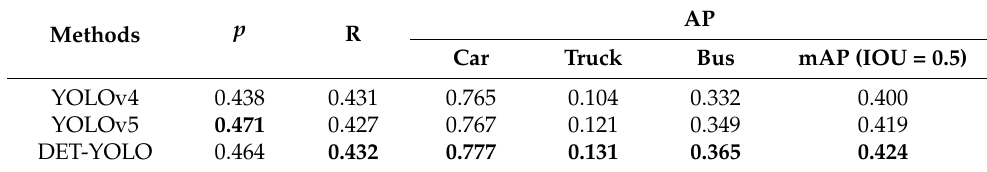
Table 6. Comparison of the performances of various models on the UAVDT dataset.